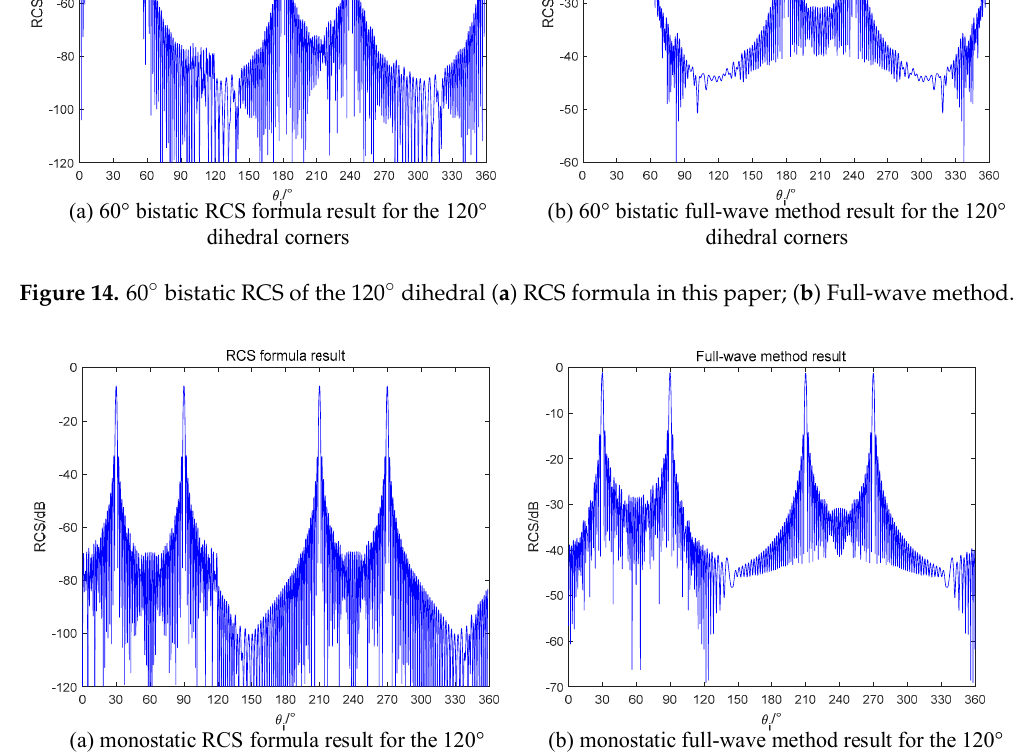
Figure 14. 60° bistatic RCS of the 120° dihedral ( a ) RCS formula in this paper; ( b ) Full-wave method.